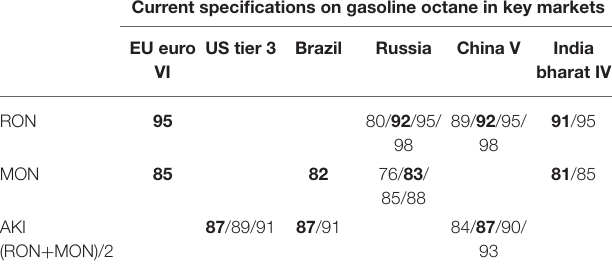
TABLE 1 | An overview of current specifications for gasoline knock resistance in 6 key markets globally. Current specifications on gasoline octane in key